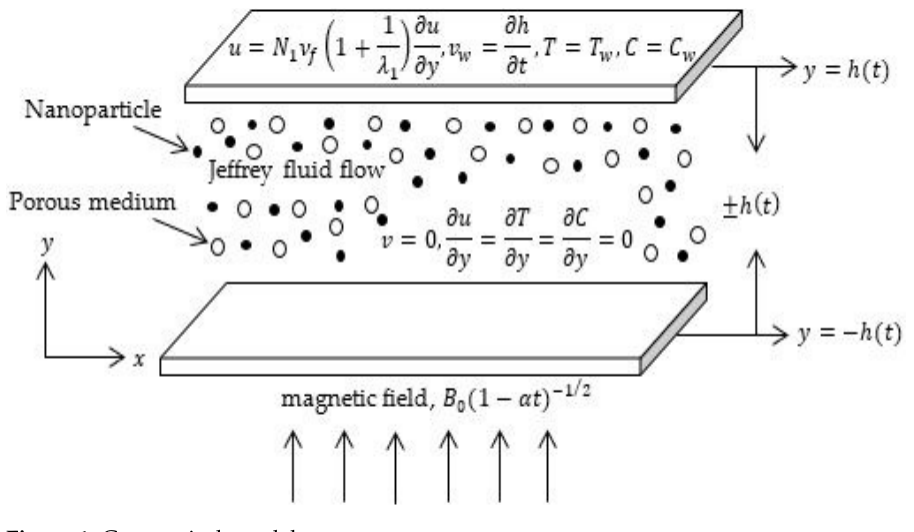
Figure 1. Geometrical